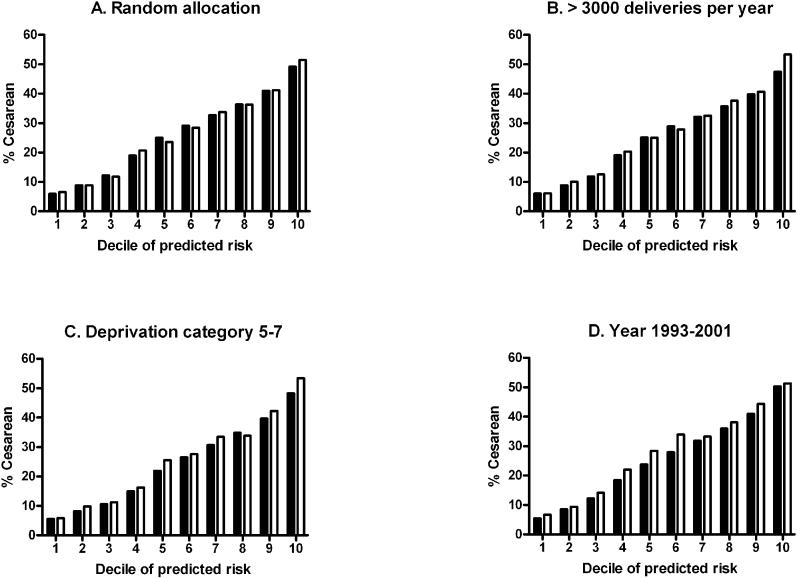
Observed and Expected Proportion of Cesarean Deliveries in the Model Validation Group by Decile of Predicted ProbabilityThe white bars indicate the observed proportion and the black bars indicate the expected proportion of cesarean deliveries, based on estimates derived from logistic regression model fitted to the development group. Different graphs represent different procedures for selecting development and validation groups: (A) random selection, (B) selected on hospital throughput, (C) selected on deprivation category (Carstairs score), and (D) selected on year of delivery. Area under the ROC curve for each model is listed in Table 3.